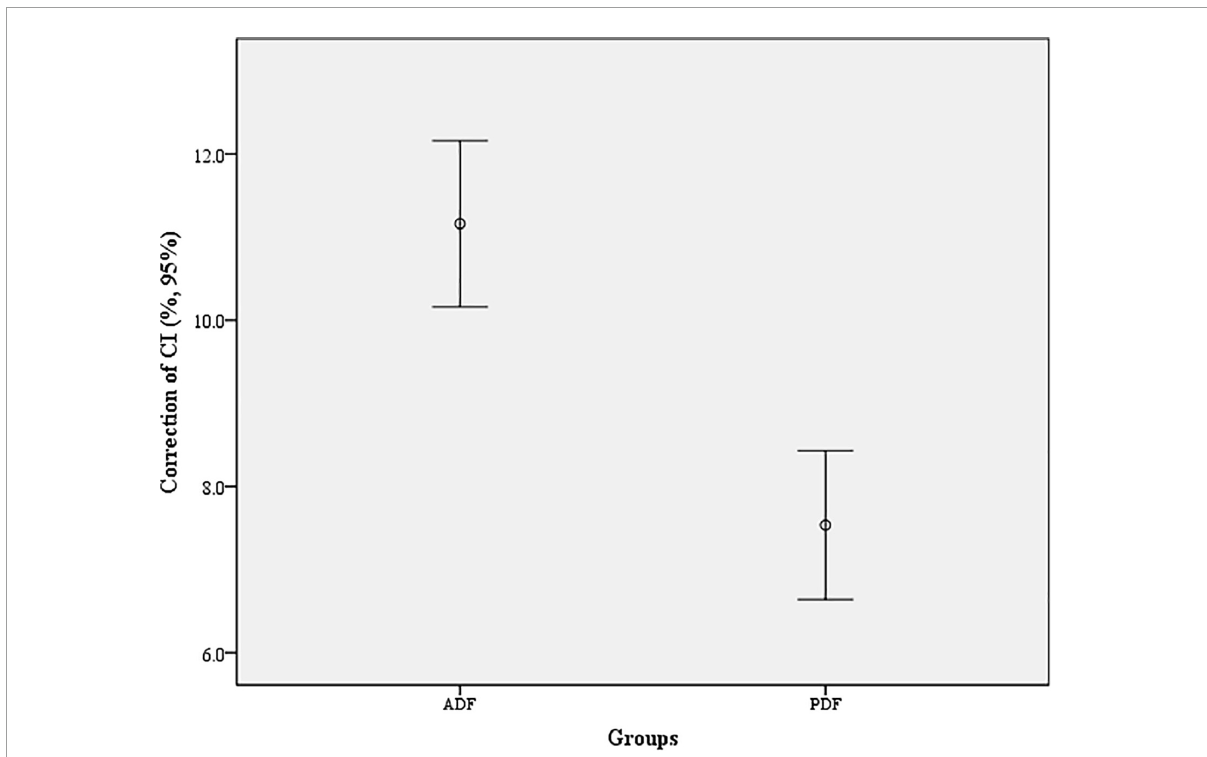
FIGURE5 Correction of cervical curvature index (CI) in each group. The difference between the two groups for correction of CI was statistically significant ( t = 5.41, P < 0.001).